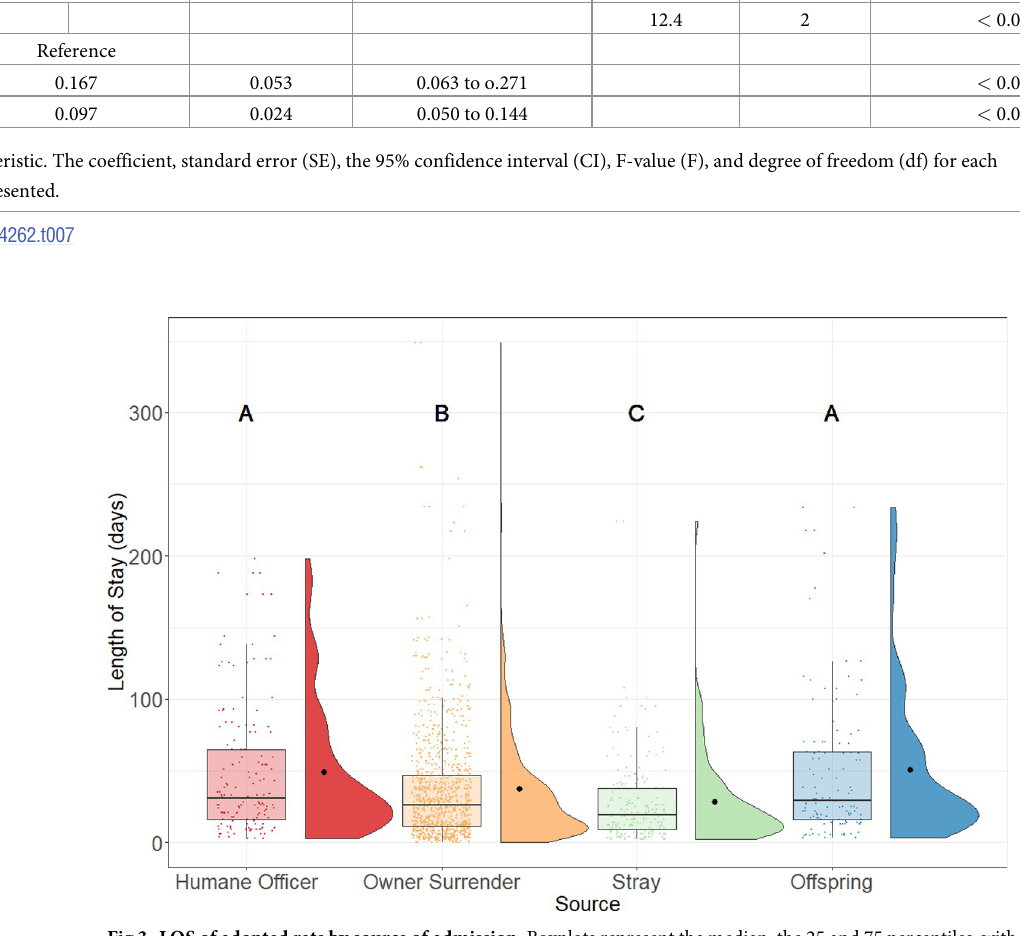
Fig 3. LOS of adopted rats by source of admission. Boxplots represent the median, the 25 and 75 percentiles, with whiskers representing the 95 percentiles. Individual data is shown by dots on the boxplot. Additionally, the rain cloud plots show the distribution and the means in each